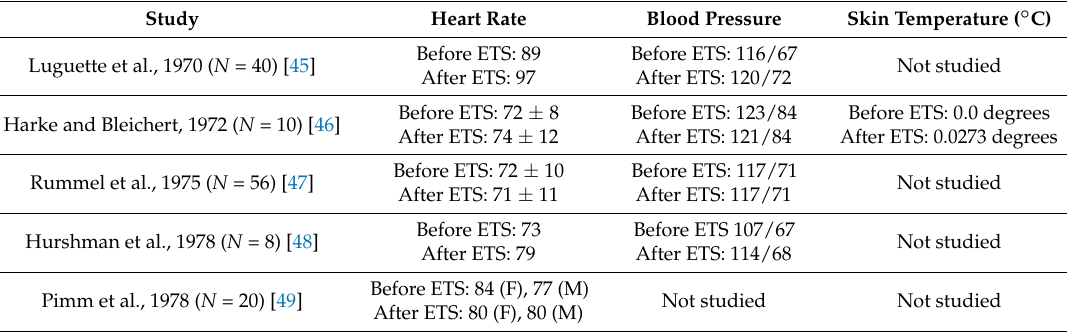
Table 2. Acute Effects of ETS on Clinical Parameters in Healthy